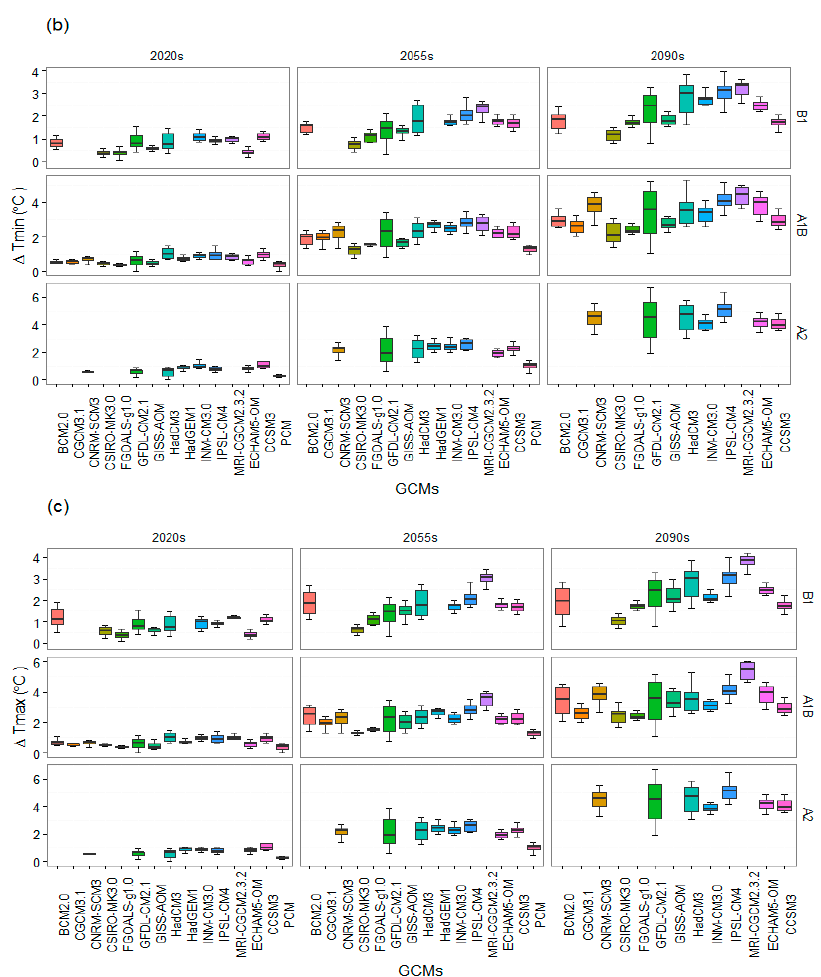
Figure 3. Uncertainties of GCMs predictions under three emissions scenarios for three future periods; GCMs predictions of monthly precipitation ( a ); Tmin ( b ); and Tmax ( c ) compared with the baseline.